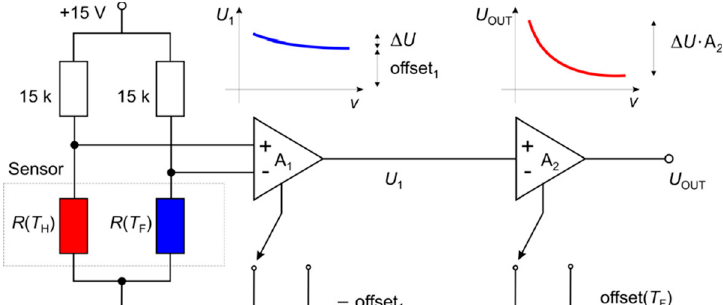
Figure 3. Schematic diagram of the signal conditioning circuit. R ( T H ) and R ( T F ) denote Pt100 elements located under the heater and upstream of the heater, respectively. Adjusting the offset of the second amplifier, the temperature dependence of the output signal can be taken into